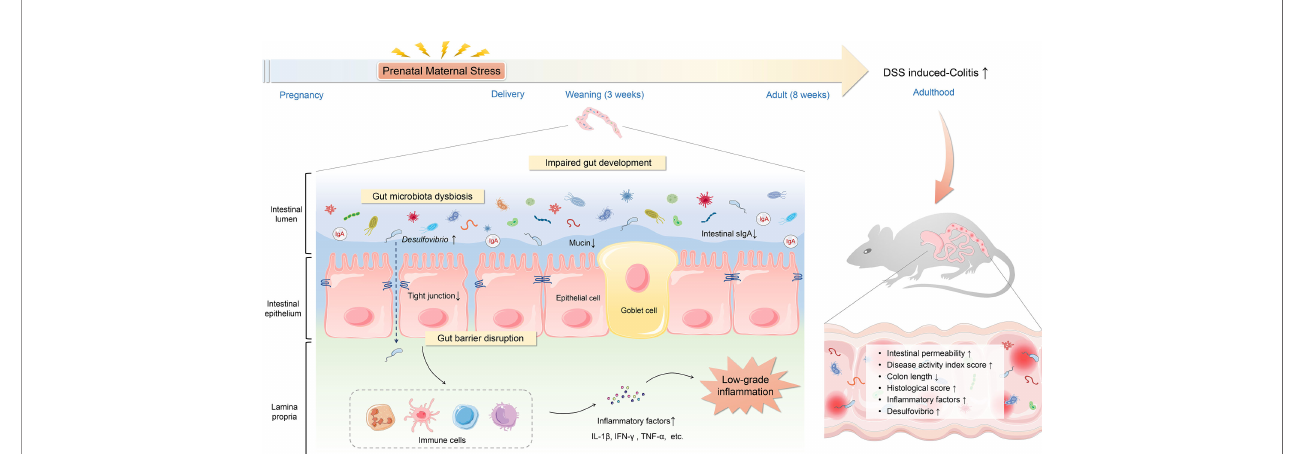
FIGURE 9 | Schematic overview of how prenatal maternal stress increases the susceptibility to colitis in adult offspring. Prenatal maternal stress can impair the intestinal development, disturb the mucosal barrier function, induce low-grade in fl ammation, alter the composition of the microbiota in offspring, and increase the susceptibility to colitis in